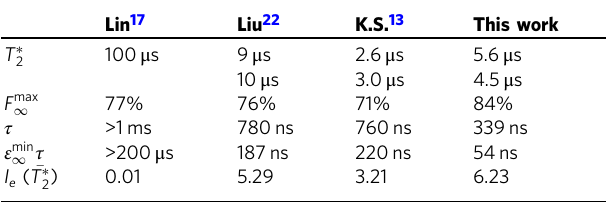
Table 1 Comparison of performance with previous